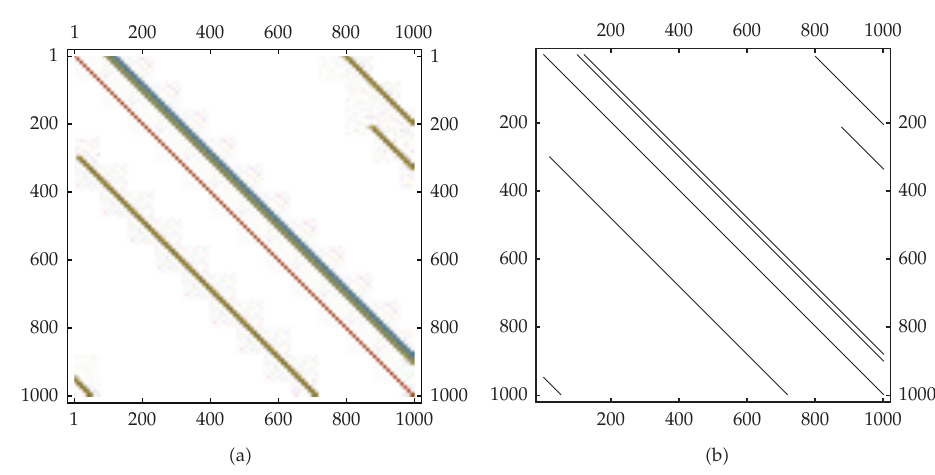
Figure 1: The matrix plot (cid:4) a (cid:5) and the array plot (cid:4) b (cid:5) of the coe ffi cient complex matrix in test problem 1. Table 1: Results of comparisons for the test problem 1. Iterative